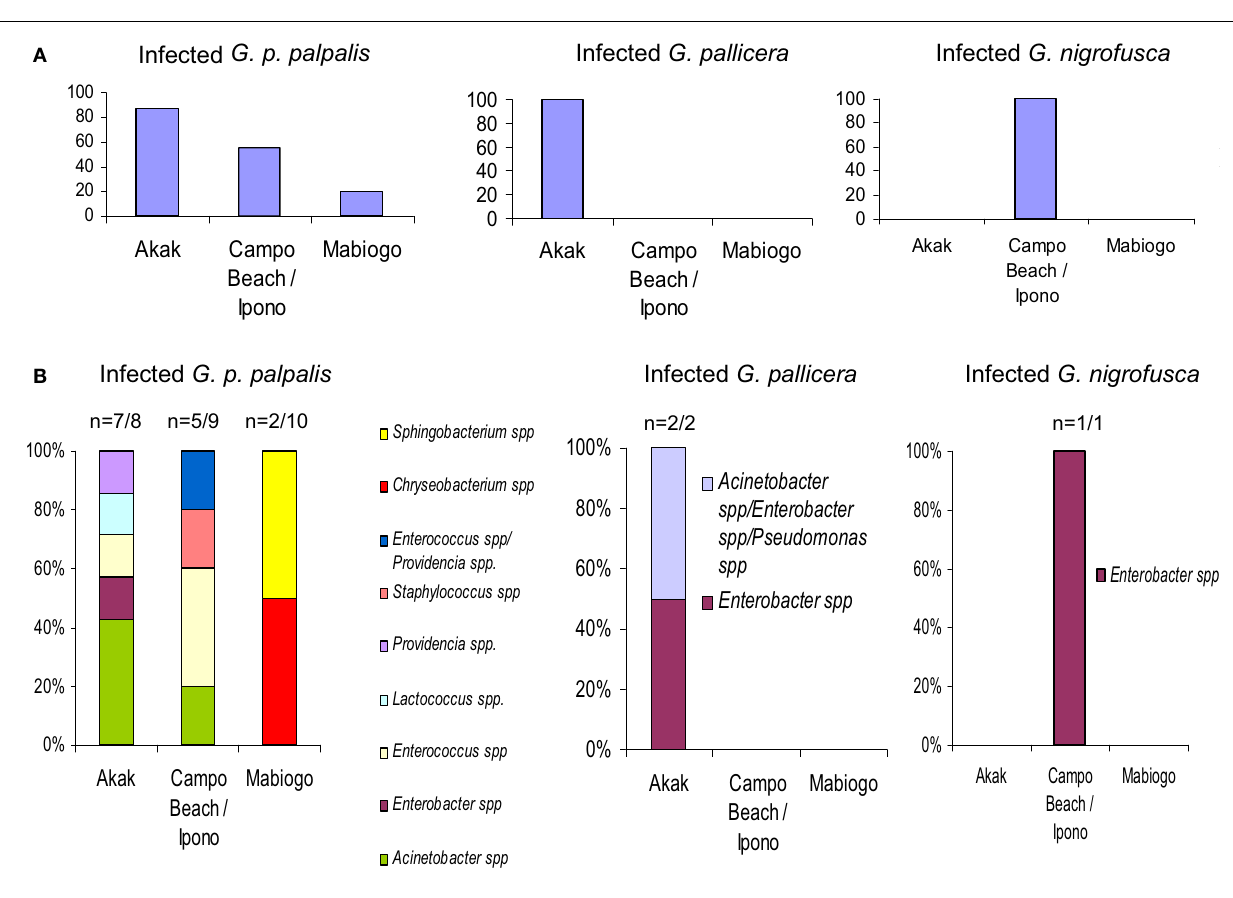
tsetse fly species; (B) bacterial infection frequency per fly species and per village. “n” indicates the number of bacterial infected flies vs. the number of collected flies. “Multiple” names indicate the occurrence of a mixed